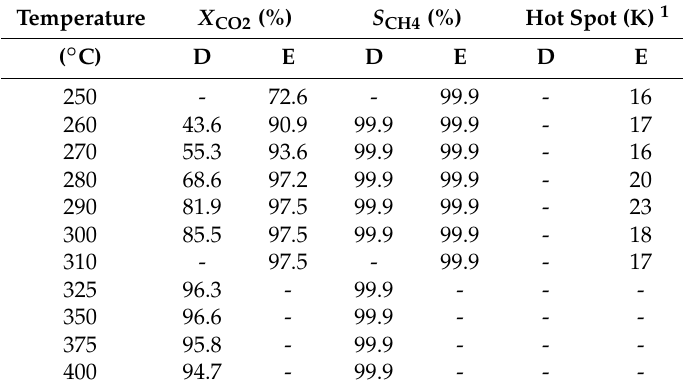
Table 3. CO 2 conversion and methane selectivity on 18Ni/Al 2 O 3 in the bench-scale reactor with single bed (run D: catalyst:quartz = 1:9; total 5 mL; GHSV = 12,000 h − 1 ) and triple-bed configuration (run E: